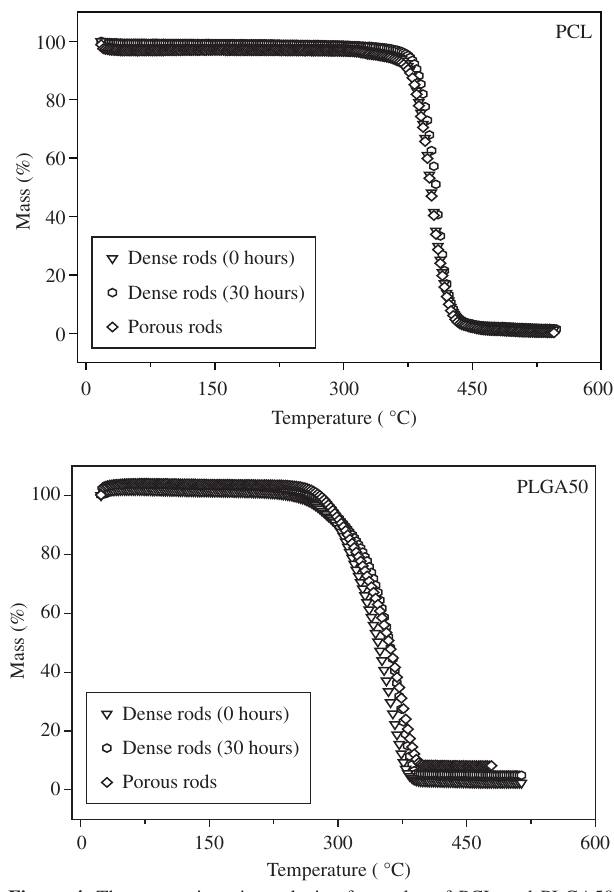
Figure 4. Thermogravimetric analysis of samples of PCL and PLGA50 prepared by melting compression process.